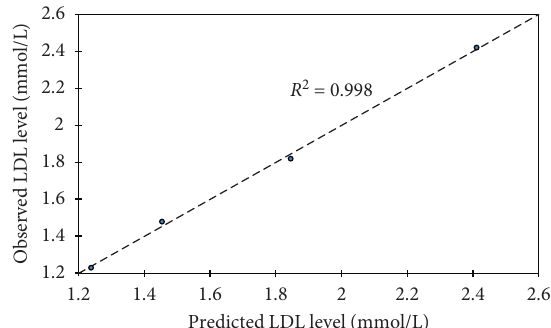
Figure 9: Predicted LDL level against observed one as a lipid profile parameter, where y � LDL levels and x � Costus afer concentrations served as input values.